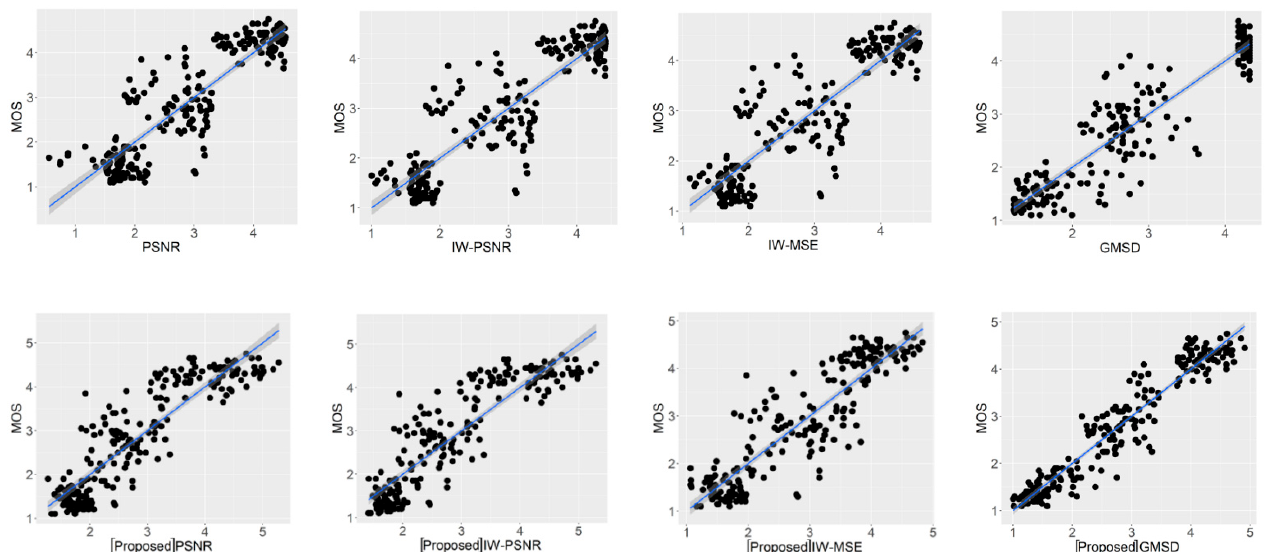
Figure 9. The difference between the PLCC and R2 performance of compared quality metrics with proposed metrics.